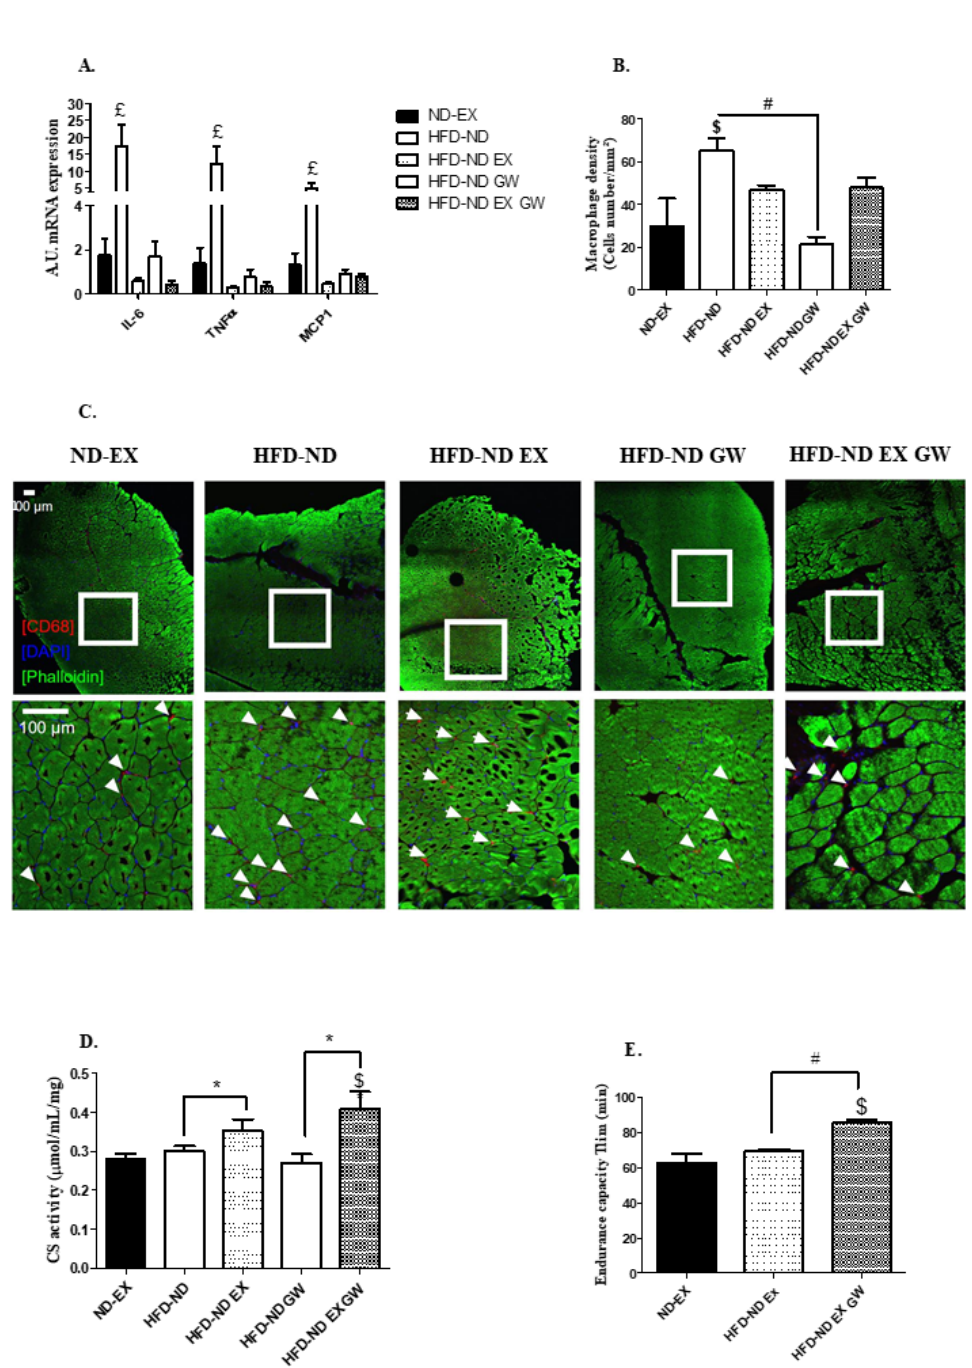
Figure 5. Inflammatory and metabolic states of skeletal muscle. ( A ) Relative mRNA levels of IL-6 , TNF- α , and MCP-1 . Data are expressed as arbitrary units of expression (A.U.) relatively to 36B4 in the vastus lateralis. ( B , C ) Macrophage infiltration by immunohistology staining with Alexa-Fluor488 (staining of actin filament) conjugated phalloidin, CD68 (staining of myeloid cells), and DAPI (staining of cell nucleus) in tibialis lateralis anterior. White borders show the selected area for magnification. White arrows represent infiltrated macrophages. Data are shown as macrophage density (cell number per mm 2 ) for ND-EX ( n = 3), HFD-ND ( n = 6), HFD -ND-EX ( n = 4), HFD-ND-GW ( n = 6), and HFD-ND-EX-GW groups ( n = 6). ( D ) Citrate synthase activity is expressed in µ mol / mL / mg of vastus lateralis tissue. ( E ) Endurance performance is expressed as the time to exhaustion in minutes of treadmill running (Tlim) for exercise trained groups (ND-EX, HFD-ND-EX, HFD-ND-EX-GW). Data are expressed as mean ± SD. n = 6 per group. # p < 0.05 GW0742 e ff ect; * p < 0.05 exercise training e ff ect (2-way ANOVAs); $ p < 0.05 vs. ND-EX; £ p < 0.05 vs. all groups (one-way